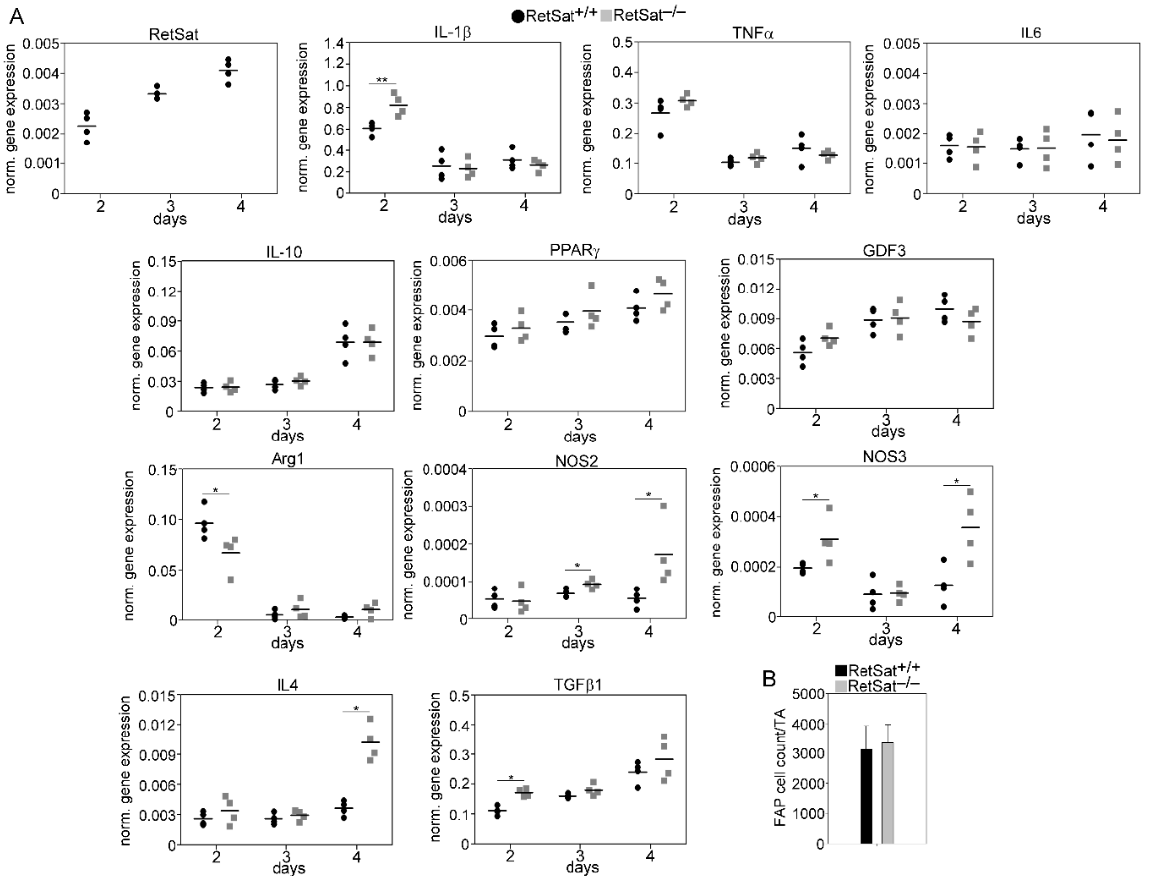
Figure 6. ( A ) mRNA expression of RetSat and of various M1-and M2-marker genes in CD45 + cells isolated from TA muscles determined by qRT-PCR at days 2, 3, and 4 post-injury ( n = 4). Asterisks indicate statistical significance (* p < 0.05, ** p < 0.01). ( B ) The number of FAP cells in CTX-injected TA muscles determined at day 4 following injury. Data are expressed as mean ± SD.